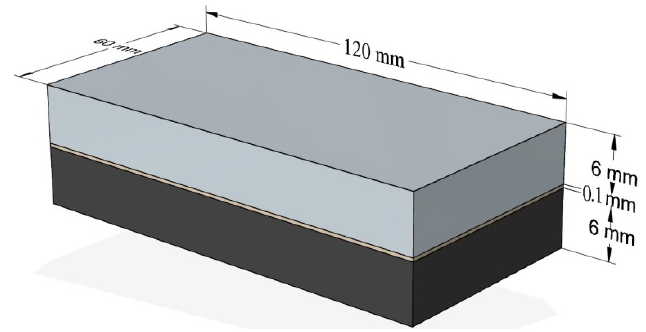
Figure 1. Shape and dimensions of sample.